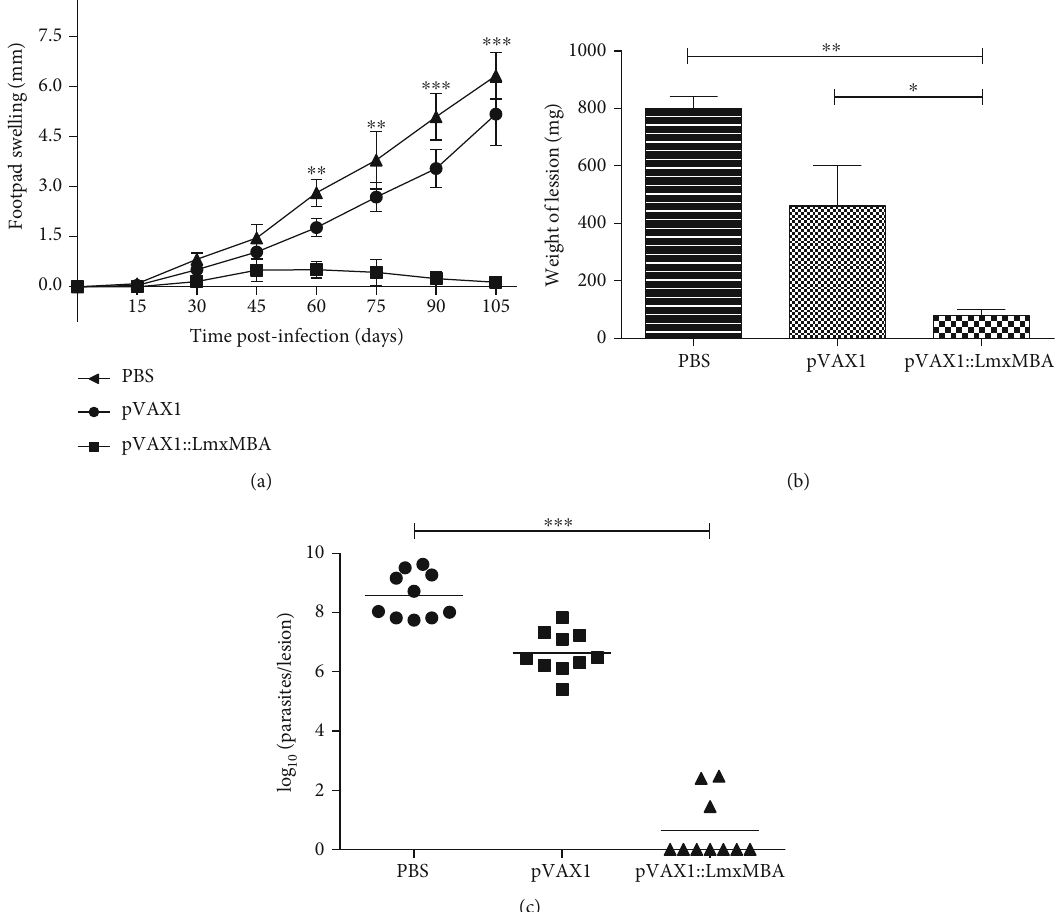
Figure 4: Footpad swelling (a), weight of lesions (b), and parasite burden (c) in BALB/c mice immunized and challenged with promastigotes of L. mexicana . Mice were immunized three times (intervals of 15 days between doses) with pVAX1::LmxMBA, pVAX1, or PBS. The results are expressed as means ± standard errorsof themean ð SEM Þ of ten mice per group (a). The weight of the lesion was determined by amputation of the paw 105 days after the infection; the di ff erence between the infected and healthy paws was taken as the net weight of the lesion (b). The number of parasites in the lesion was determined by limiting dilution culture, and the results are expressed as log ∗ p < 0 : 05